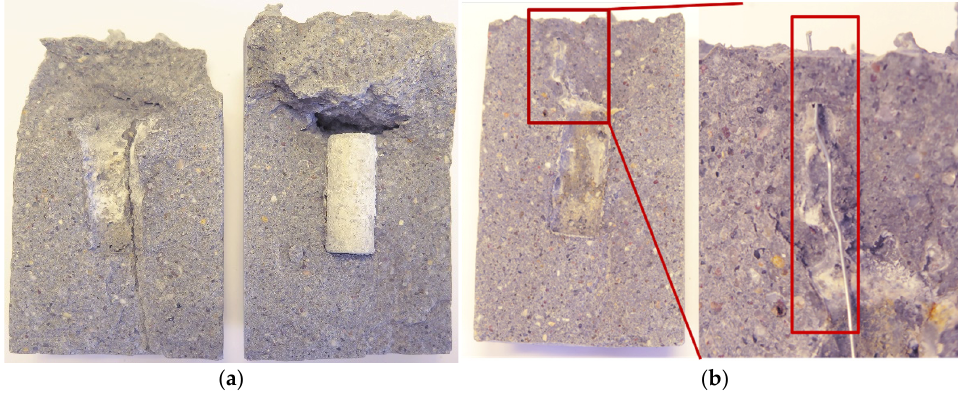
Figure 4. ( a ) Voids formed at the top end of the Al sample embedded in concrete and ( b ) Gas vent leading from the top of the void to the outer upper surface of the concrete cylinder.